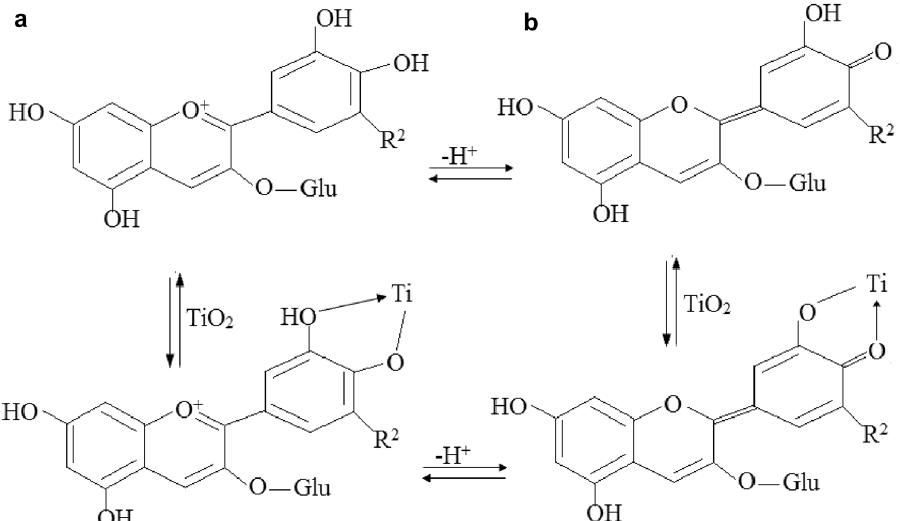
Fig. 3 Schematic representation of attachment of cyanidine- 3-glucoside (anthocyanin) onto TiO 2 a flavylium, b quinonoidal form and upon adsorption onto TiO 2 the equilibrium between the forms is believed to shift towards the quinonoidal form, consistent with the purple col- oration of the